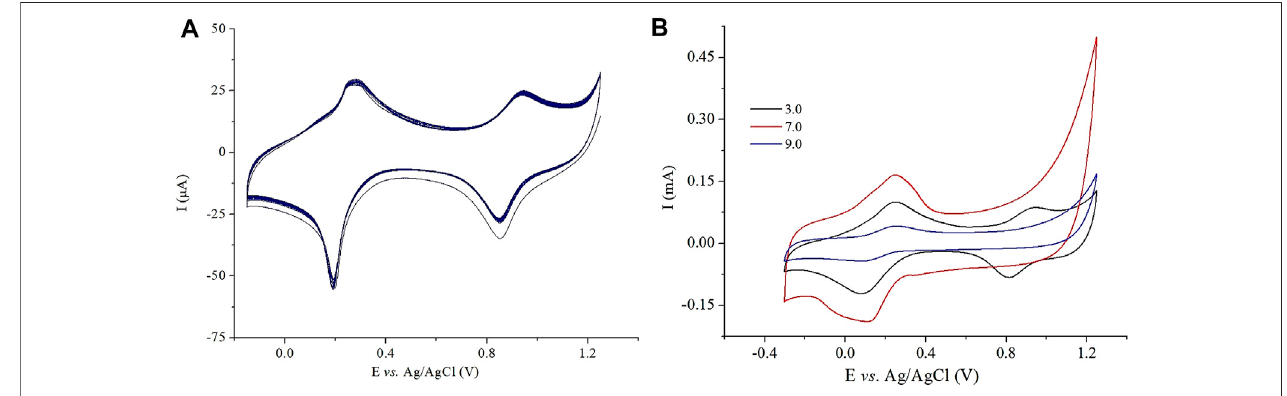
FIGURE 10 | Cyclic voltammetry at the PB-fCNT/TiO 2 .ZrO 2 (36)500 ° C.20/GC-modi fi ed electrode in (A) PBS (pH 3), 40 mV/s, and 90 cycles; (B) PBS, pH 3.0, 7.0, and